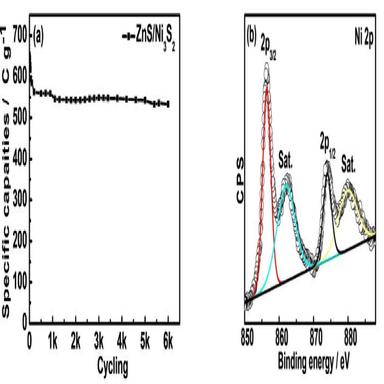
(a) Stability test of ZnS/Ni3S2 electrode at 10 A g1 for 6000 cycles; (b) Ni2p high resolution XPS spectrum after 6000 cycles. "Sat" in Fig. 6b denotes satellite peaks.